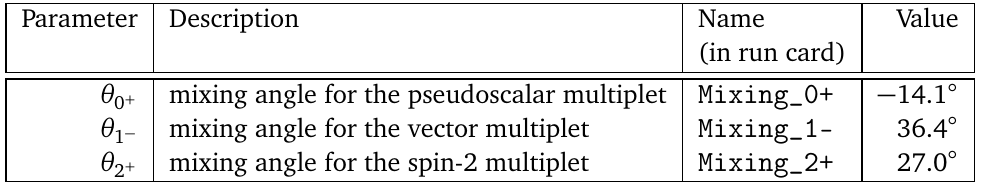
Table 1: Angles parameterising the singlet-octet mixing of